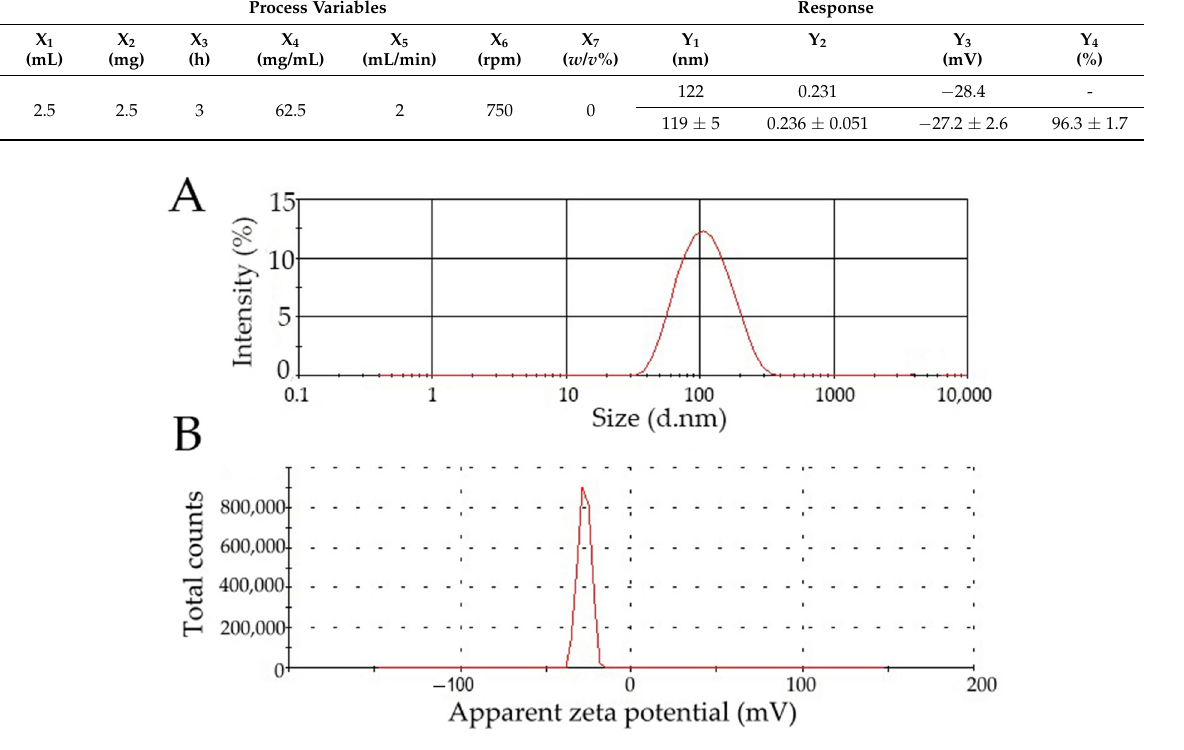
Figure 6. Particle size distribution ( A ) and zeta potential plot ( B ) of optimized HSA nanoparticles. Table 12. Model confirmation of the design of the experiment: X 1 : Amount of EtOH (mL), X 2 : Amount of crosslinker (EDC) (mg), X 3 : Incubation time (h), X 4 : Concentration of HSA (mg/mL), X 5 : Ethanol flow rate (mL/min), X 6 : Stirring speed (rpm), X 7 : Concentration of NaCl ( w / v %), Y 1 :